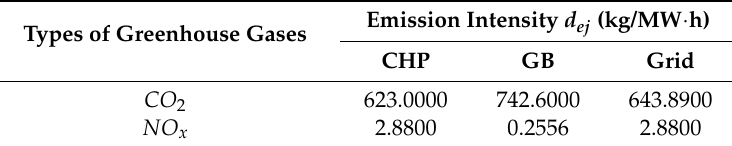
Table 1. Emission intensities of different devices.